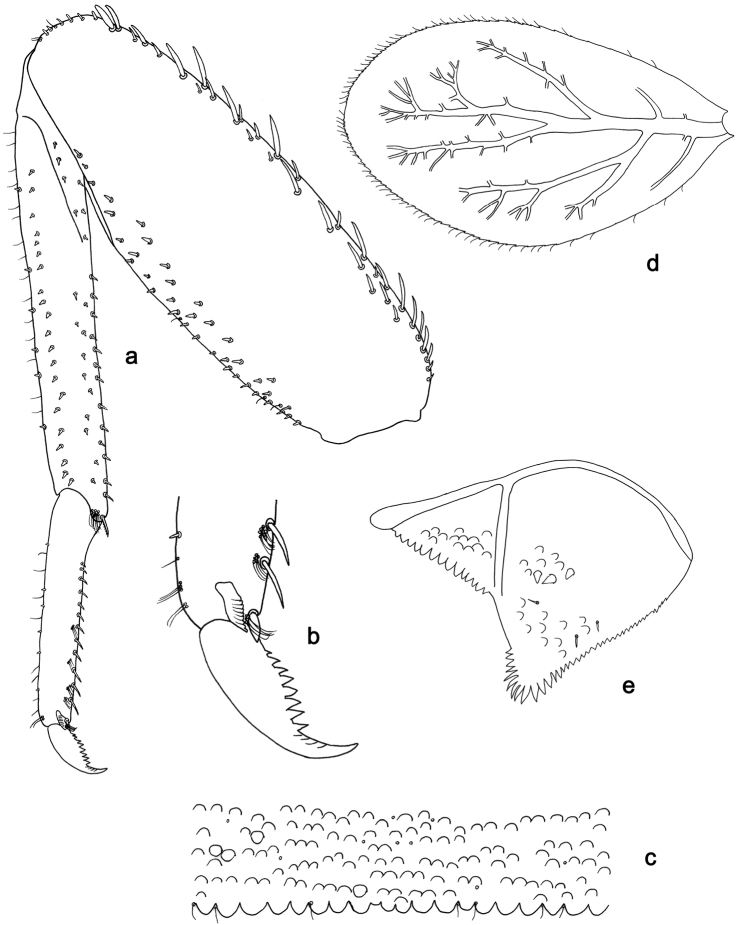
Labiobaetisplanus sp. n., larva morphology: aForelegb Fore claw cTergum IV d Gill IV eParaproct.